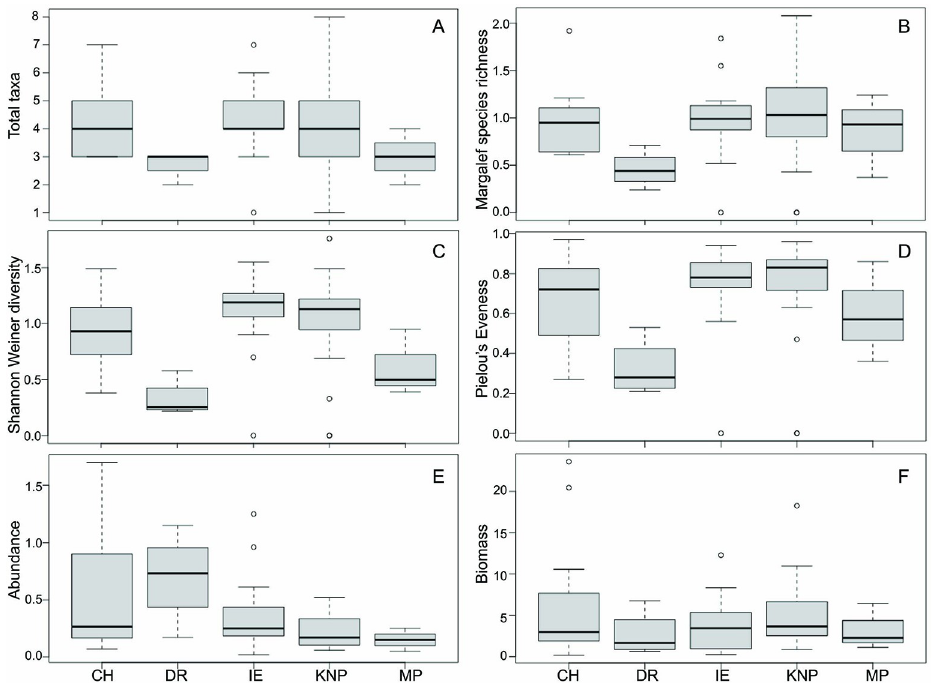
Fig 2. Fish assemblage characteristics among sampling stations. A. Total taxa, B. Species richness (Margalef), C. Shannon-Weiner Diversity, D. Pielou’s Evenness, E. Number of individuals m -2 , F. Biomass (g m -2 ).